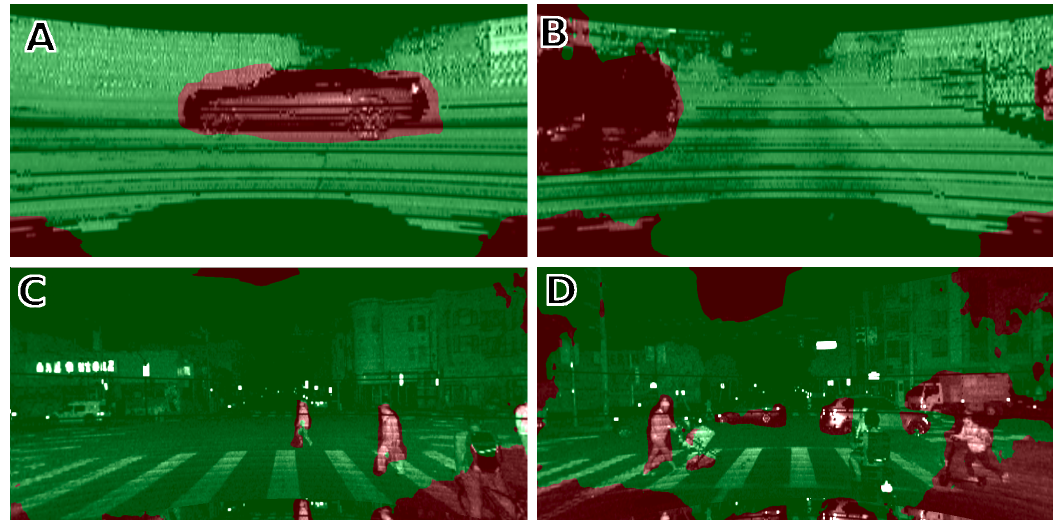
Figure 7. Unsupervised motion segmentation (Competitive Collaboration) from Velodyne HDL-64E ( A , B ) and OS1-128 ( C , D ). The network correctly detects cars passing in front of the sensor ( A ), but also those moving on the sides, out of the field of view of a typical frontal camera ( B ). OS1-128 images make it also possible to segment out pedestrians ( C , D